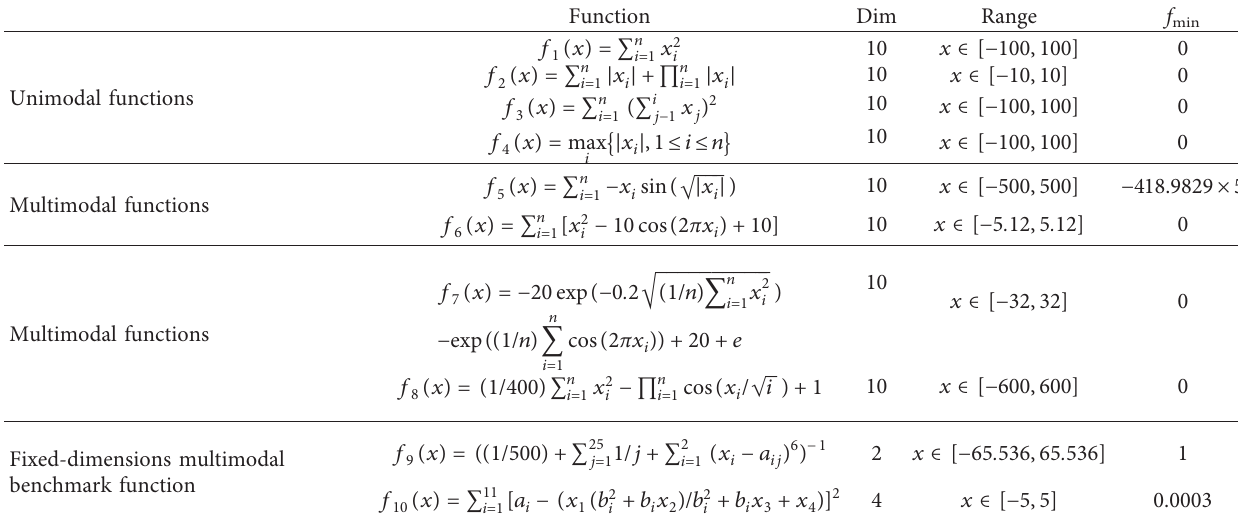
Table 2: The setting of benchmark functions.